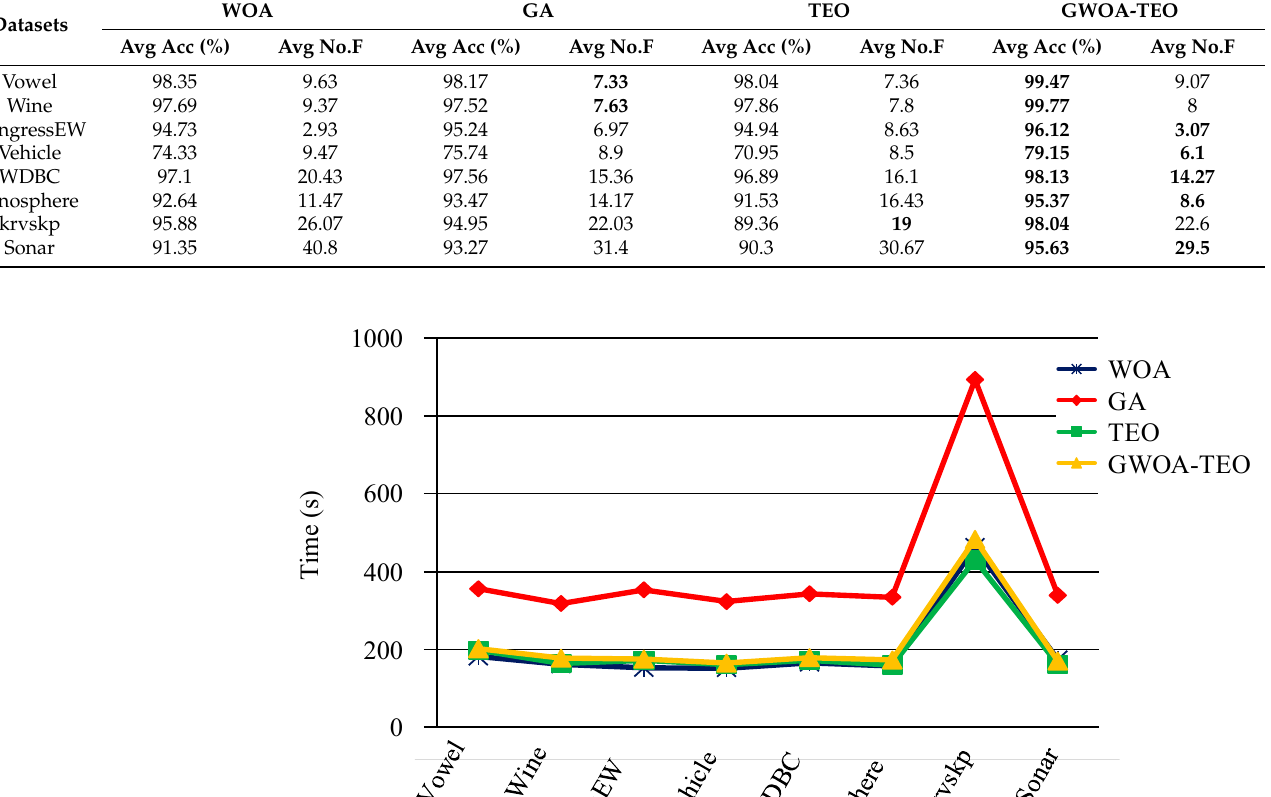
Table 6. Comparison between GWOA-TEO and the other algorithms.